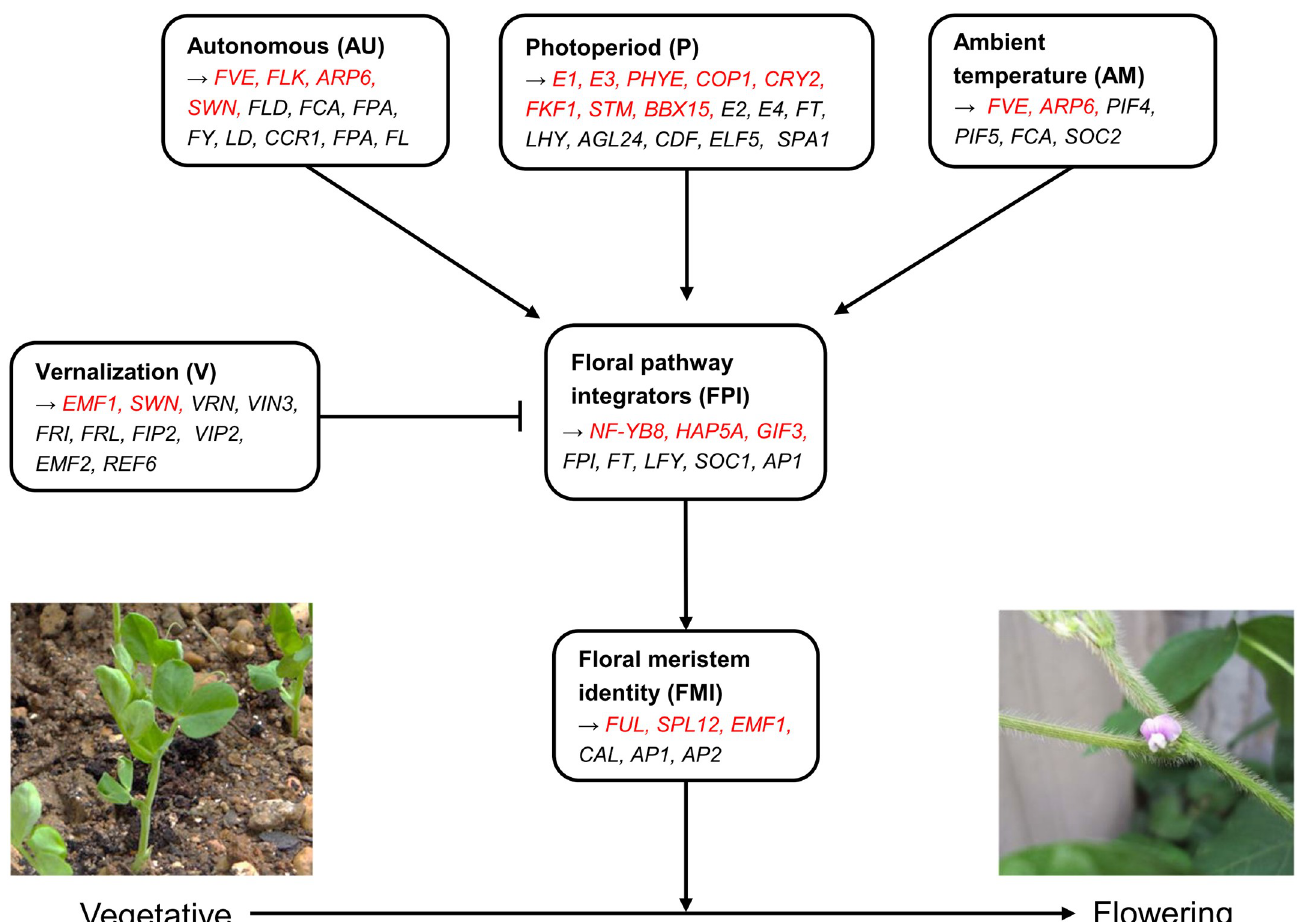
Fig 4. Genes in major pathways regulating plant growth from the vegetative stage to the flowering stage. Representative genes are displayed in corresponding pathways. Candidate genes identified from interaction groups are shown in red (“Related pathway” column in Table 2).